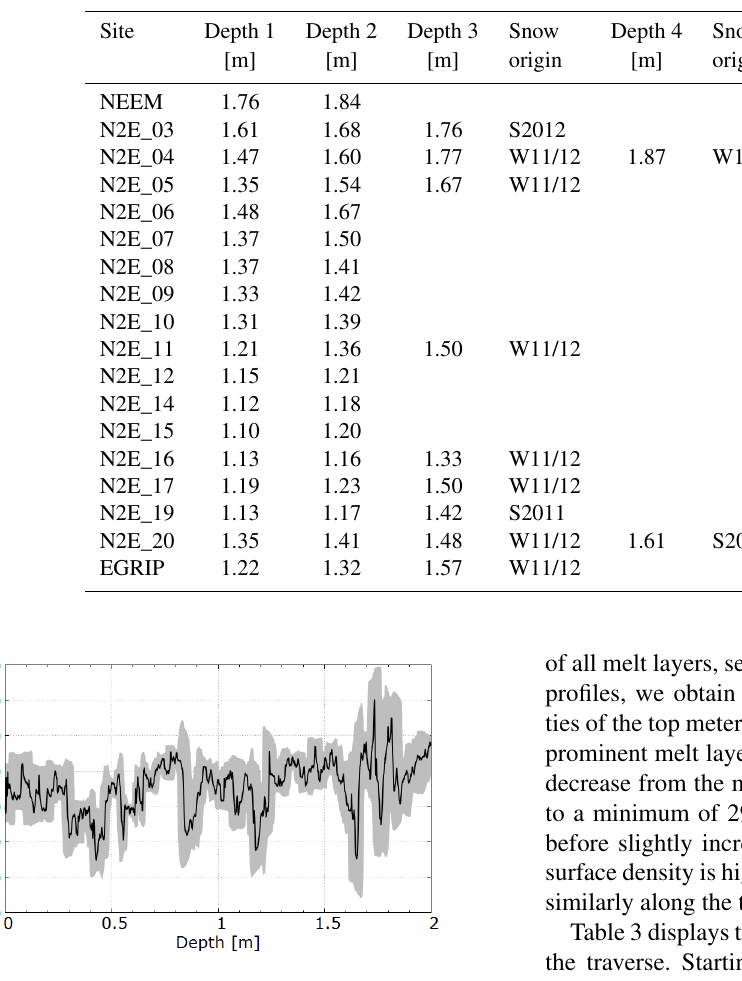
Figure 7. Representative density profile for the traverse region. The gray area indicates a 1 standard deviation error band in both x and y directions as there are uncertainties in the depth alignment as well as the averaged densities of all sites. Here, the depth scale was ad- justed to the NEEM accumulation rate and has to be rescaled ac- cording to the accumulation rate for different